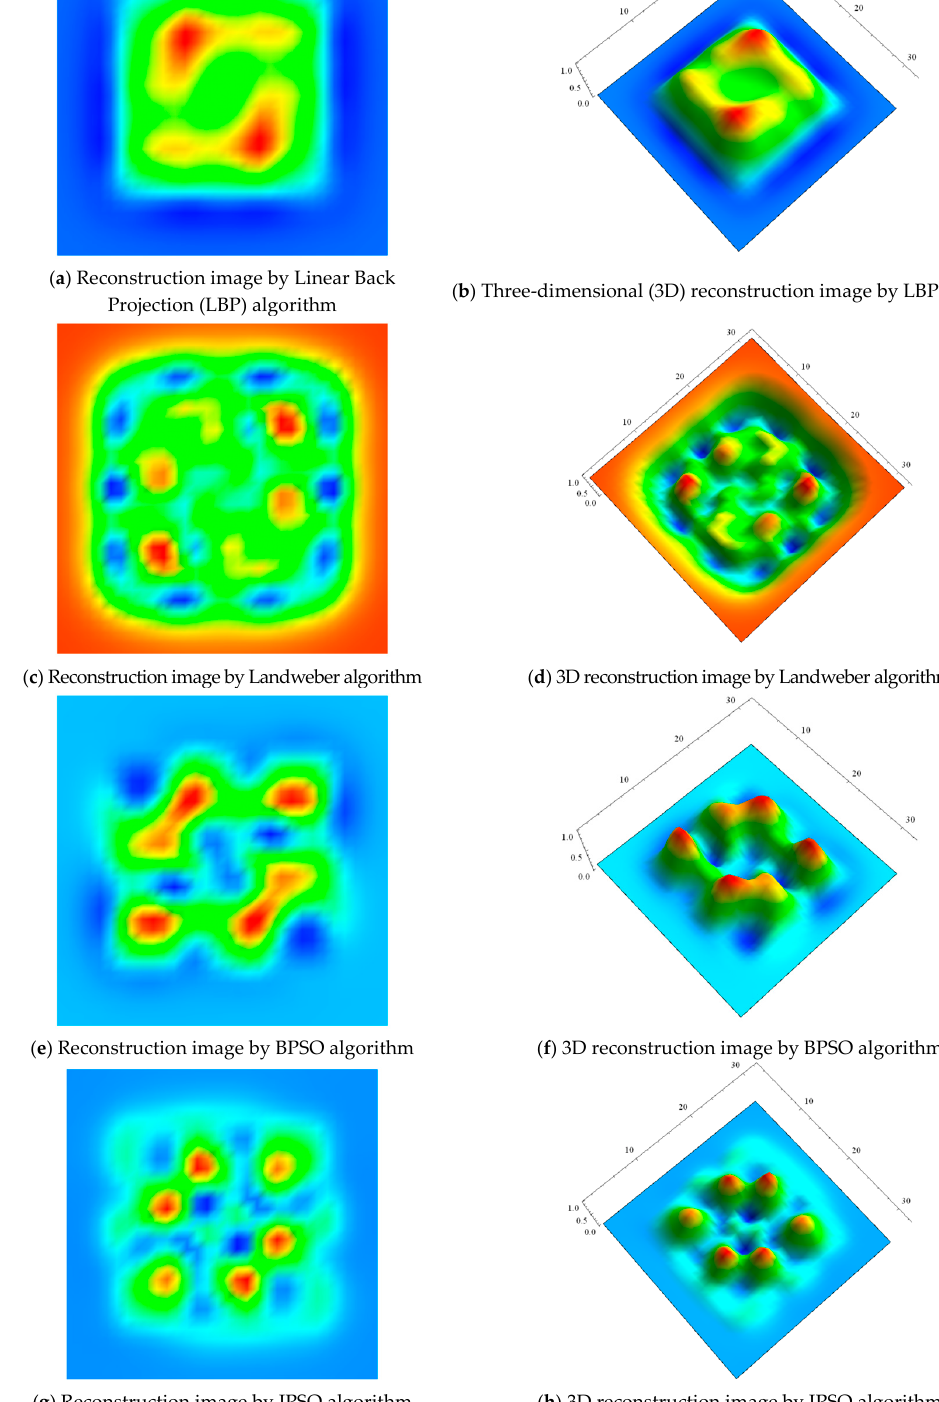
Figure 5. Images reconstructed by different algorithms for Sample 1.